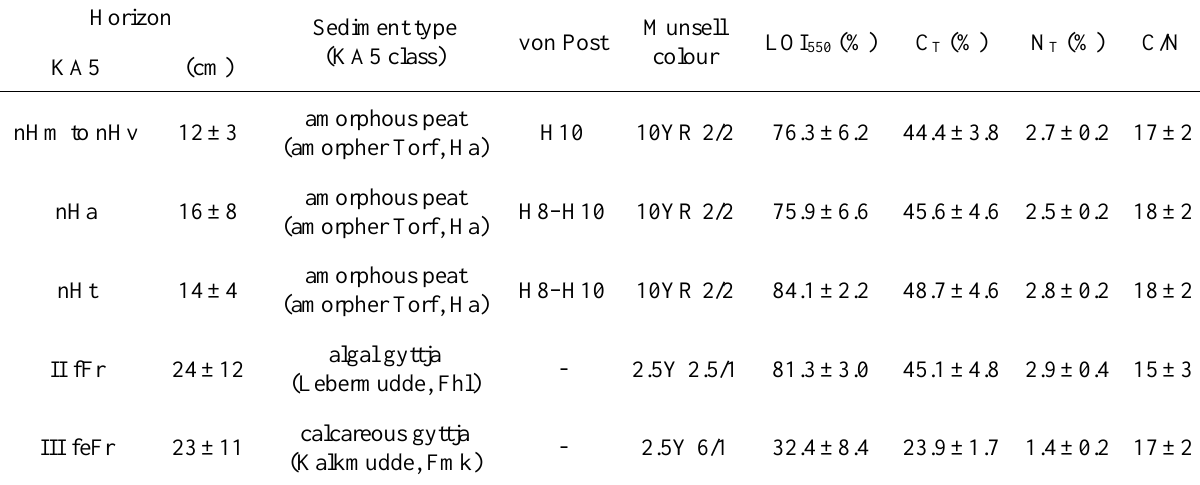
Table 1. Summary of the main peat characteristics from ten soil profiles. The soil was sampled in November 2016 and classified according to KA5 (Ad-Hoc-AG Boden 2005). Numerical data are given as mean ± standard